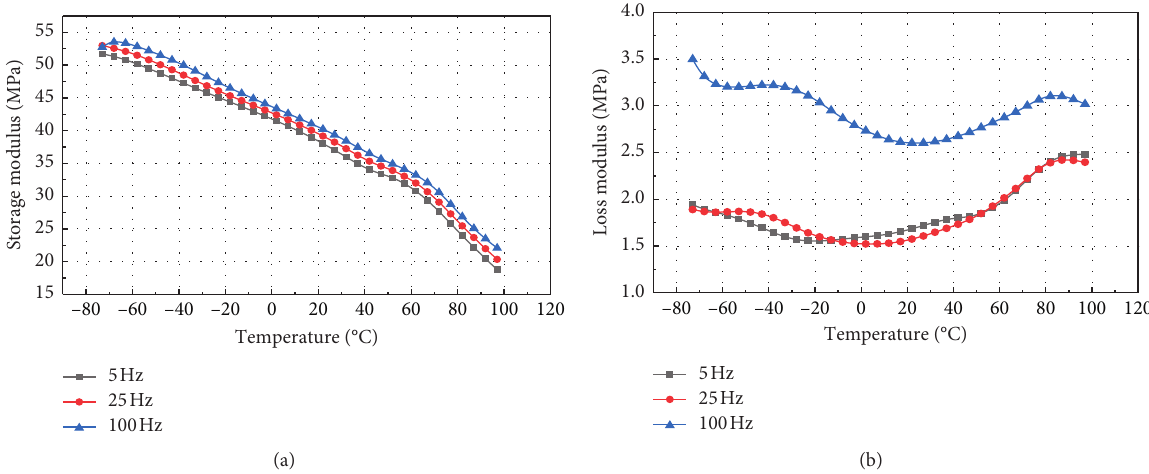
Figure 5: Dynamic modulus temperature spectrum of PU foam (175kg/m 3 ) at different frequencies. (a) Storage modulus. (b) Loss modulus.